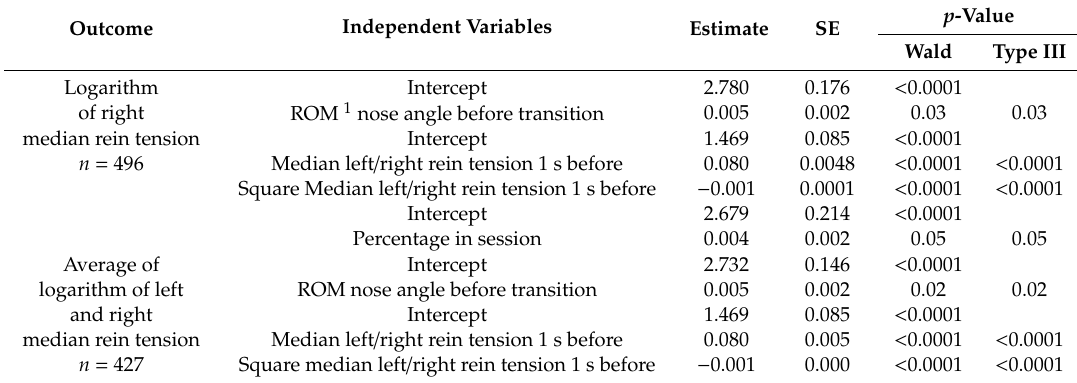
Table 2. Model estimates with standard errors (SEs) from the exploratory a) mixed models where p <